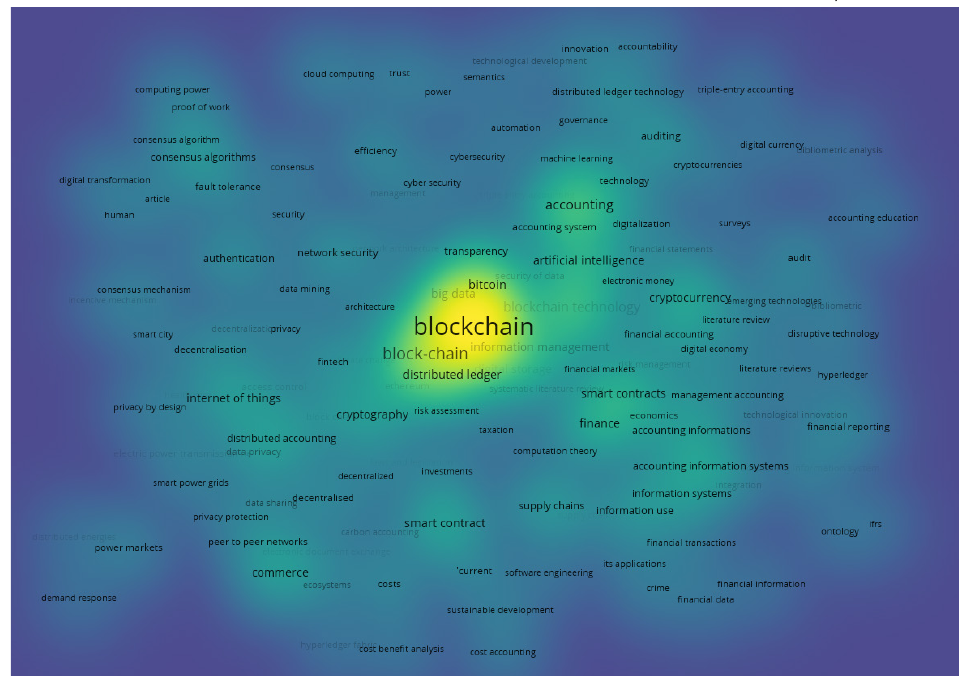
Figure 5. Map of the density of links between concepts in the context of the study “blockchain” AND “accounting” based on publications in